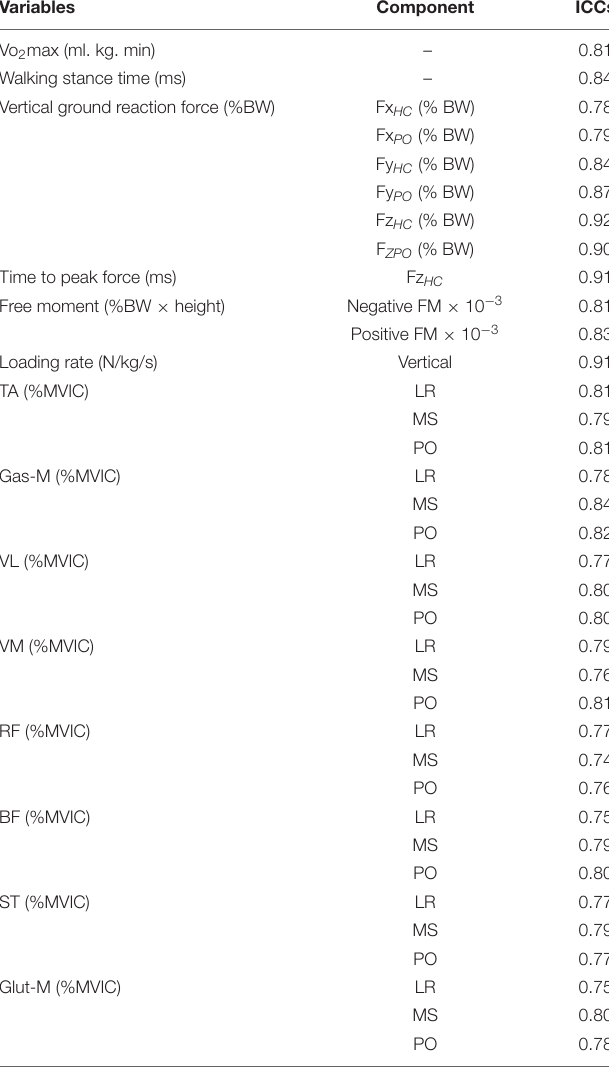
TABLE 2 | Intraclass correlation coefficients (ICC) for all analyzed variables using pre, post data from the waiting control group.